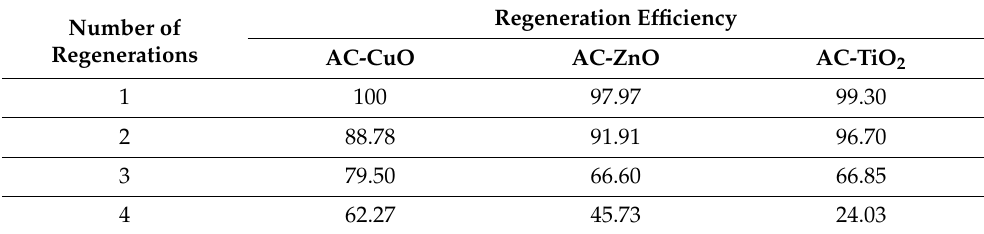
Table 7. Influence of regeneration numbers on the removal effect of methylene blue.